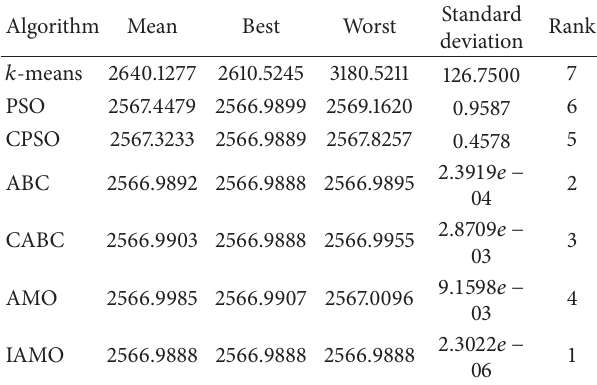
Table 8: Results obtained by the algorithms for 20 different runs on Hagerman’s survival